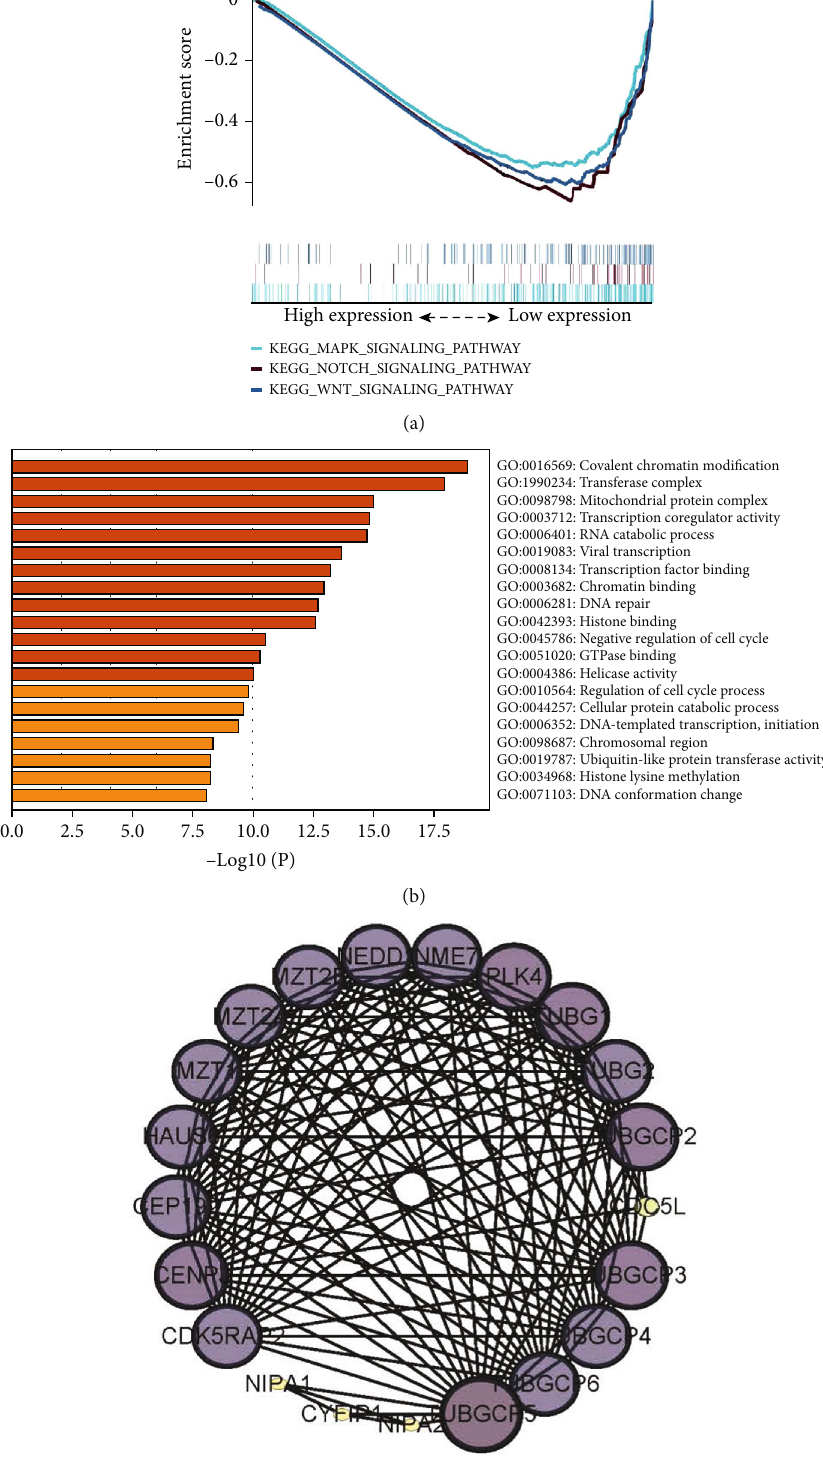
Figure 3: Bioinformatic analysis of TUBGCP4 in HCC. (a) The main enriched GSEA pathways. (b) GO analysis. The darker the color, the closer the target gene is involved. (c) Protein-protein interaction (PPI)